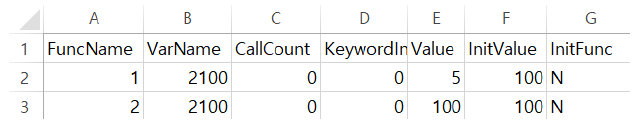
Figure 9. Example of train.csv